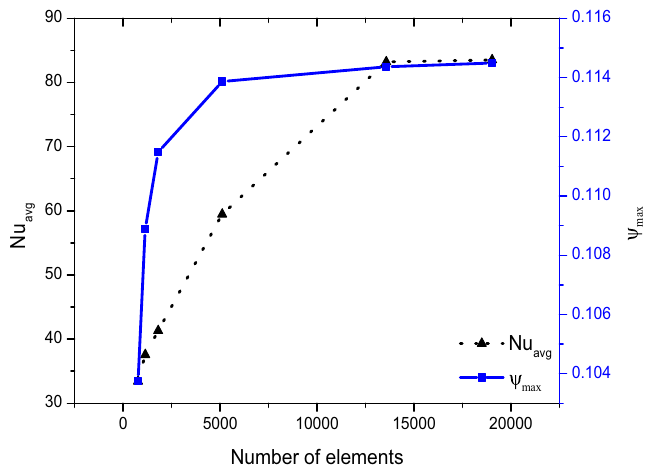
Figure 2. Validation with grid independence at Re = 200 , Ha = 0 , Ri = 1 .